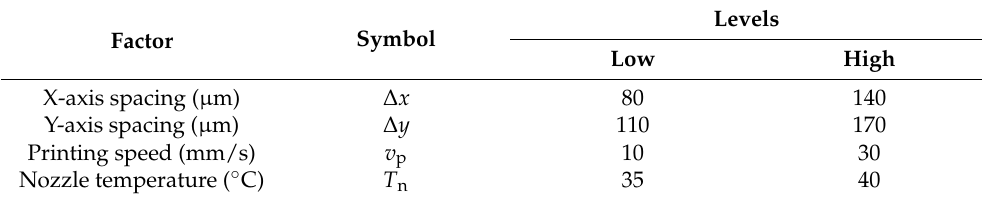
Table 1. Experimental design